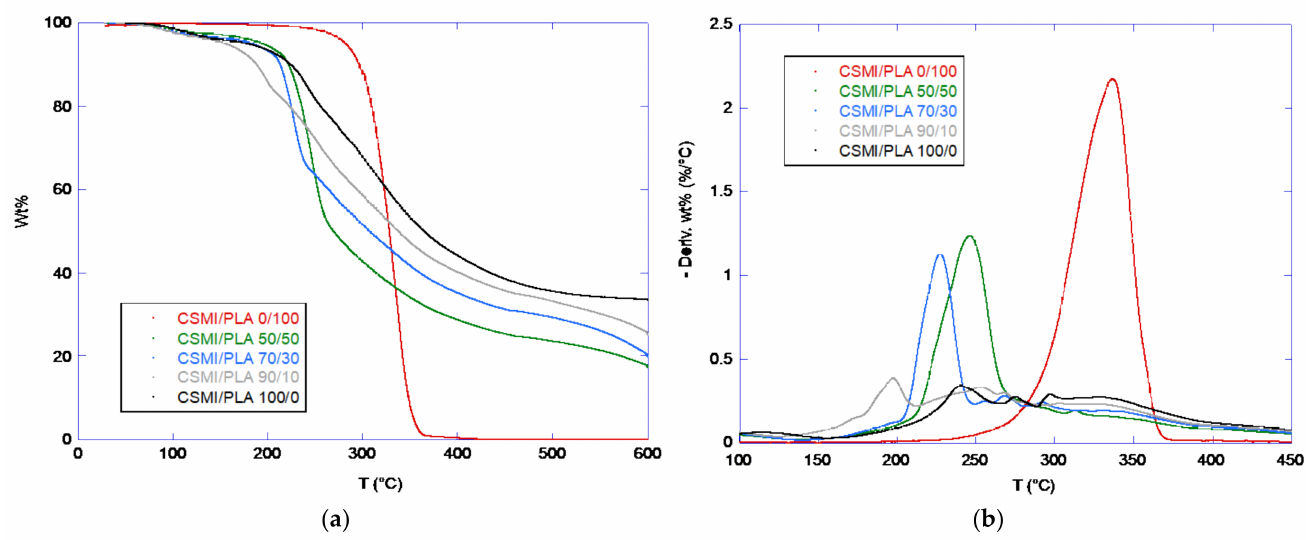
Figure 2. TGA ( a ) and DTG ( b ) data for the five bilayer film samples.